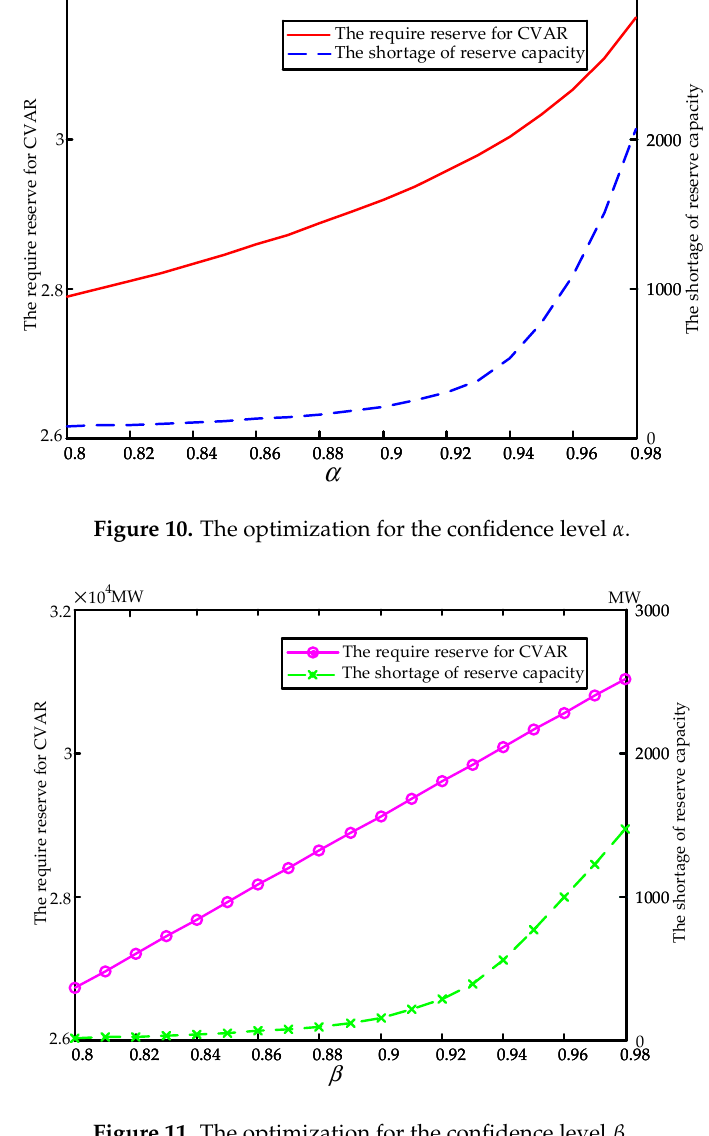
Figure 11. The optimization for the confidence level β .